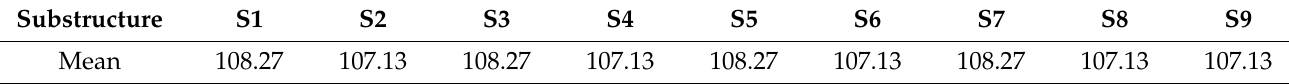
Table 4. Selected fourth-order frequency means (Hz).